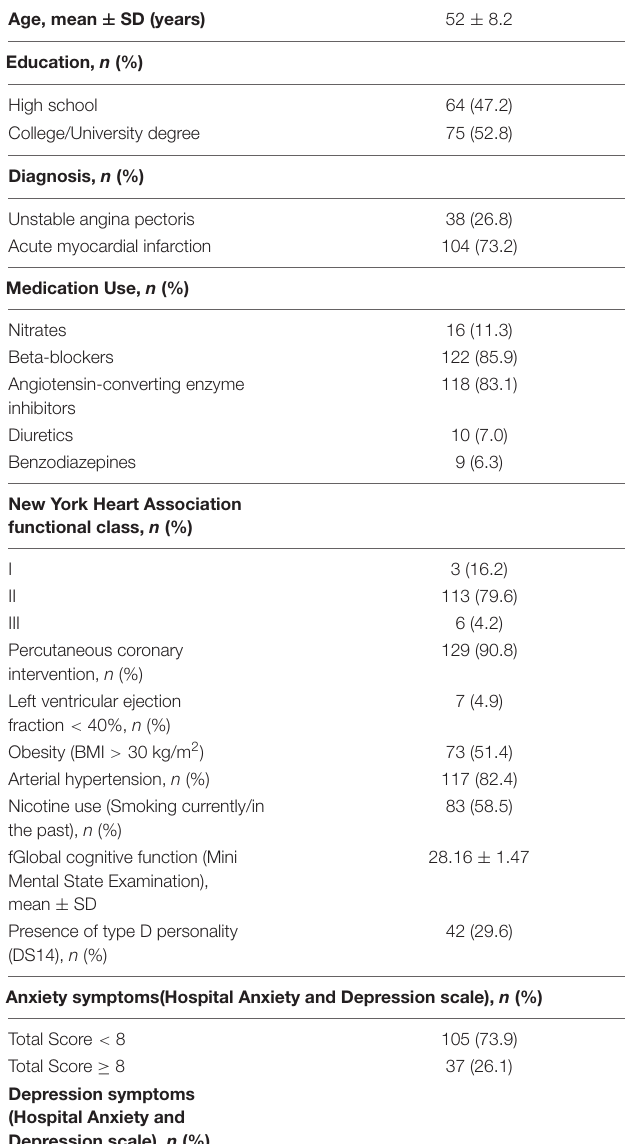
TABLE 2 | Descriptive statistics for demographics and clinical characteristics ( n =